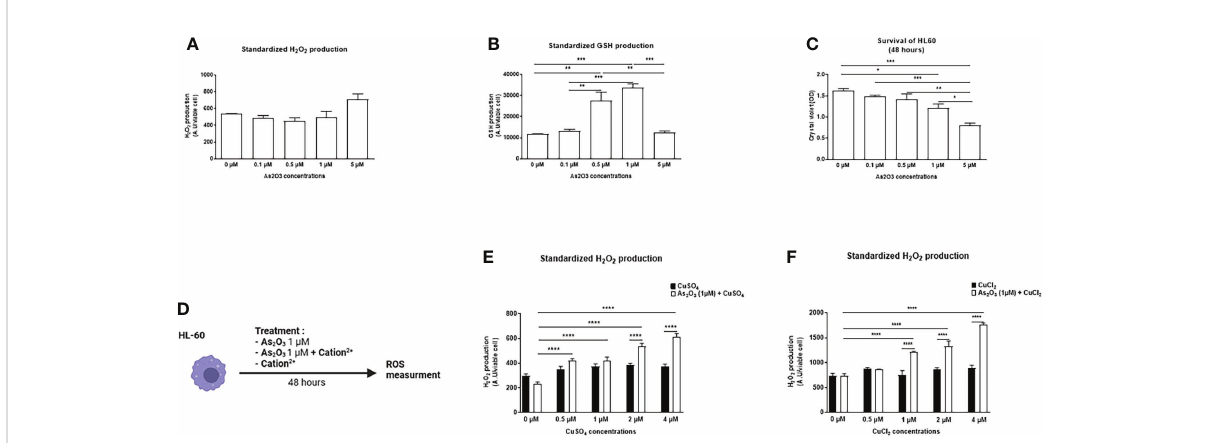
FIGURE 1 Effects of ATO ± Cu 2+ on H 2 O 2 and GSH levels and cell viability on HL-60 cell line. (A) Standardized H 2 O 2 level produced by HL-60 cells in culture after treatment during 48 hours with increasing concentrations of ATO (0 to 5 µM). H 2 DCFDA was measured by spectro fl uorometry and the results (AU) were divided by cell viability established by colorimetry (crystal violet). (B) Standardized GSH level produced by HL-60 cells in culture after treatment during 48 hours with increasing concentrations of ATO (0 to 5 µM). The results obtained by spectro fl uorometry using monochlorobimane were divided by cell viability established by colorimetry (crystal violet). (C) Cell viability of HL-60 cells in culture measured after treatment during 48 hours with increasing concentrations of ATO (absorbance at 550 nm) using a Fusion spectro fl uorometer. (D) Schematic representation of the in vitro experiment on HL-60 cells. The cells were treated for 48 hours with ATO at 1 m M +/- different divalent cations. The production of hydrogen peroxide was measured by spectro fl uorometry. (E, F) Standardized H 2 O 2 level produced by HL-60 cells in culture after treatment during 48 hours with one concentration of ATO (1 µM) and with increasing concentrations of CuSO 4 /CuCl 2 (0-4 µM). H